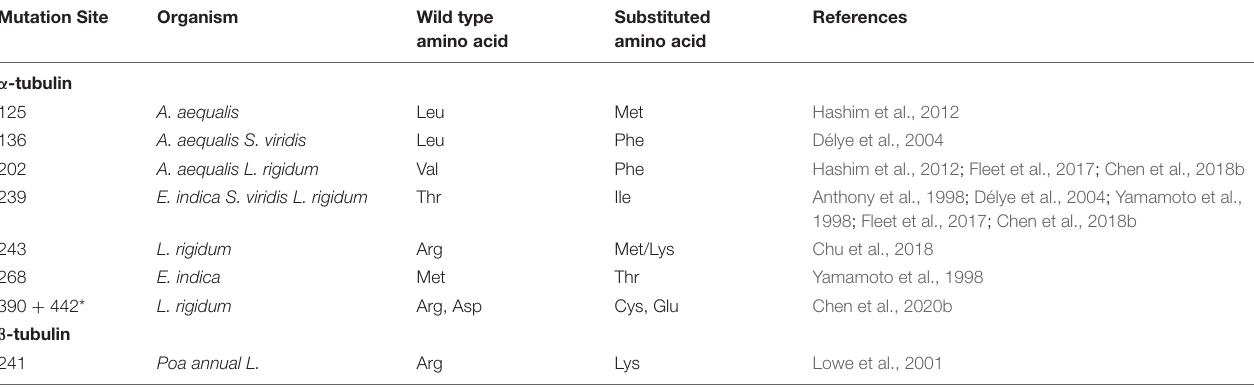
TABLE 1 | Mutations in α - and β -tubulin identified in field-evolved dinitroaniline-resistant plants. Mutation Site